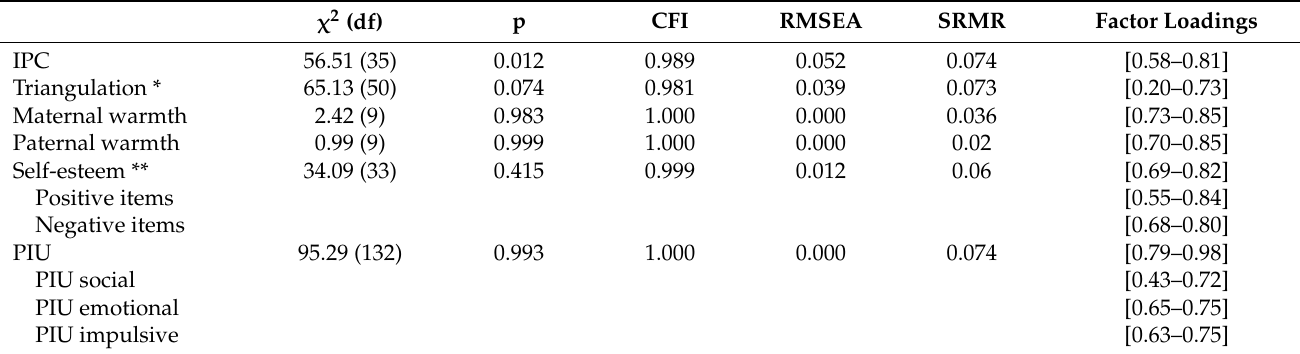
Table 1. Model fit statistics and factor loadings for the different confirmatory factor analyses